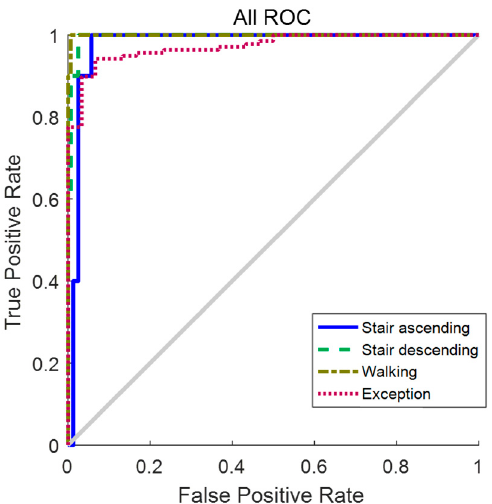
Figure 14. ROC curve. The trained neural network has good performance because the ROC curve of all states is right upward.